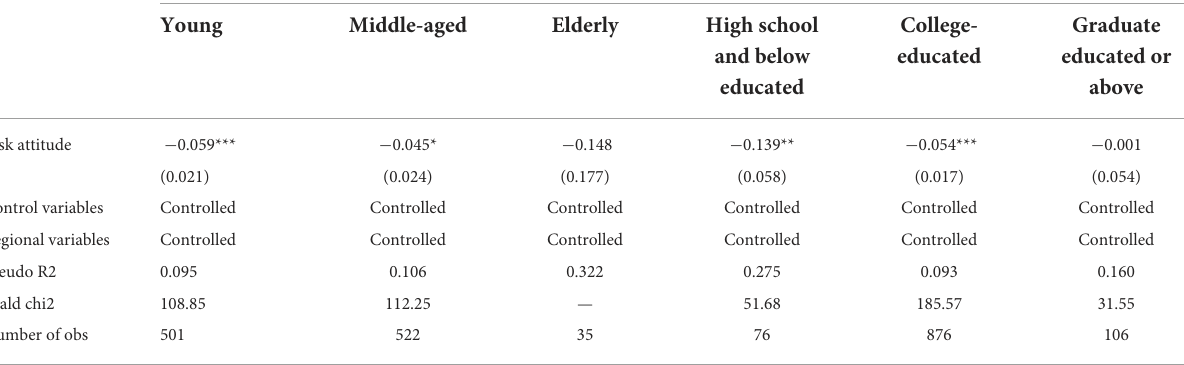
TABLE 4 Results of heterogeneity